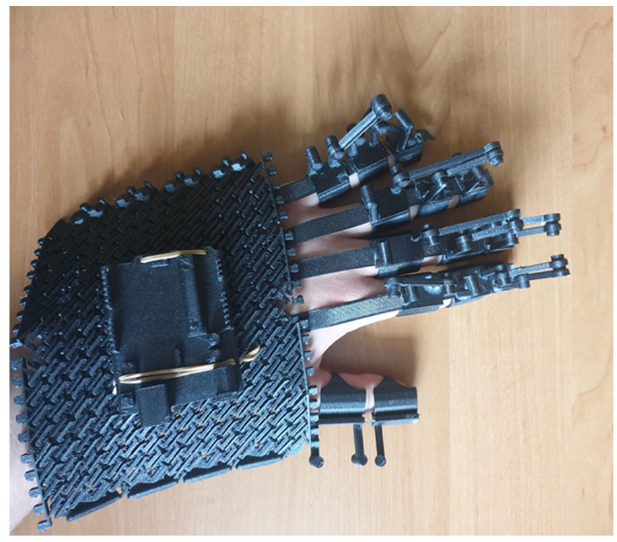
Figure 11. Chainmail on hand exoskeleton.